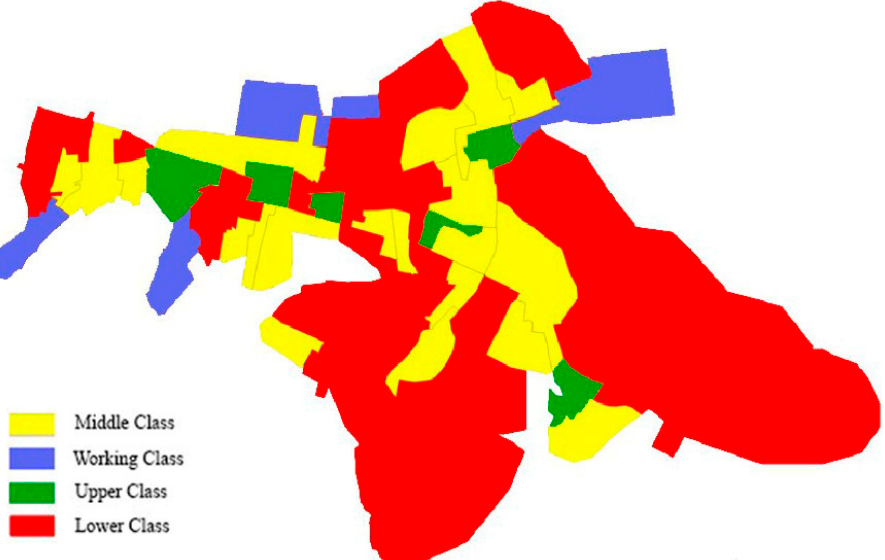
Figure 4. Geographic distribution of welfare in Mahabad.